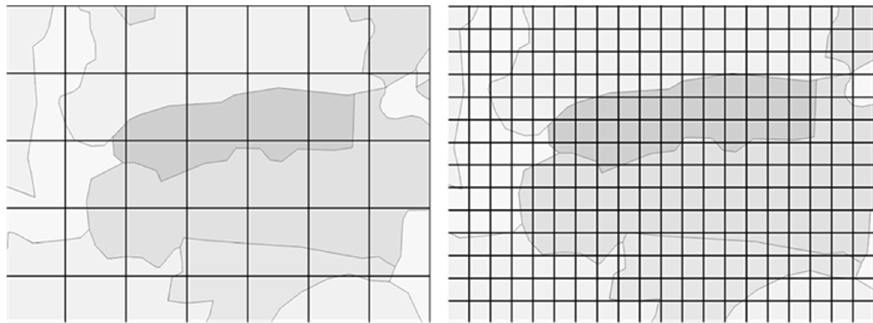
Figure 1. Influence of raster cell size on the resulting representation of the region of interest.